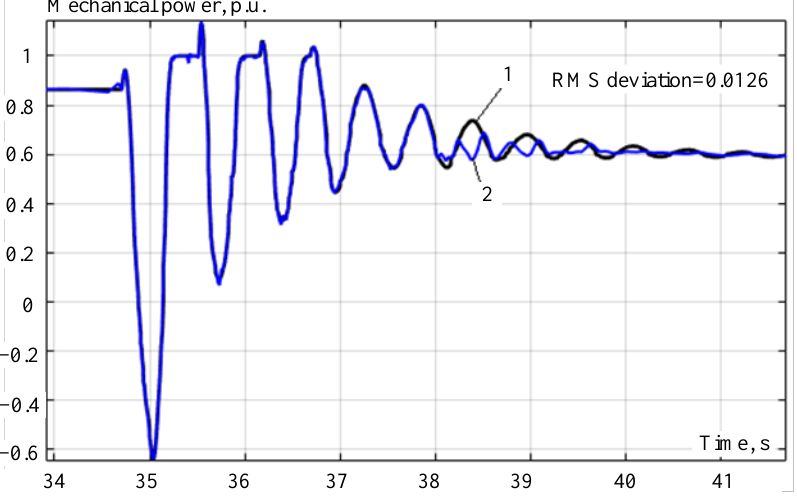
Figure 13. Results of the experimental data and fuzzy model response: 1 — experimental data; 2 — optimized trained fuzzy model (144 rules).